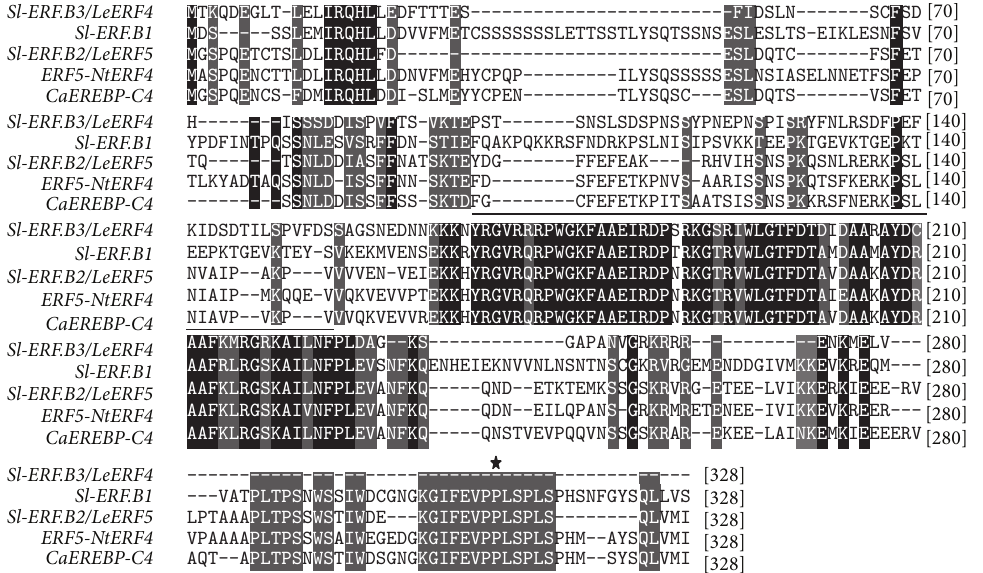
Figure 6: Multiple amino acid sequence alignment of tomato Sl-ERF.B.3 with related amino acid sequences of tomato Sl-ERF.B.1 , tomato Sl- ERF.B.2 , Capsicum annuum CaEREBP-C4 (AAX20037.1), and Nicotiana tabacum NtERF4/ERF5 (Q40478.1). Conserved residues are shaded in black. Dark grey shading indicates similar residues in four out of five of the sequences. Alignments were made in ClustalW using the default parameters. The black bar above the sequences represents the ERF domain. Star represents putative MAP kinase phosphorylation site absent in Sl-ERF.B.3 sequence. Dashes show gaps in the amino acid sequences introduced to optimize alignment. Numbers show the positions of amino acid